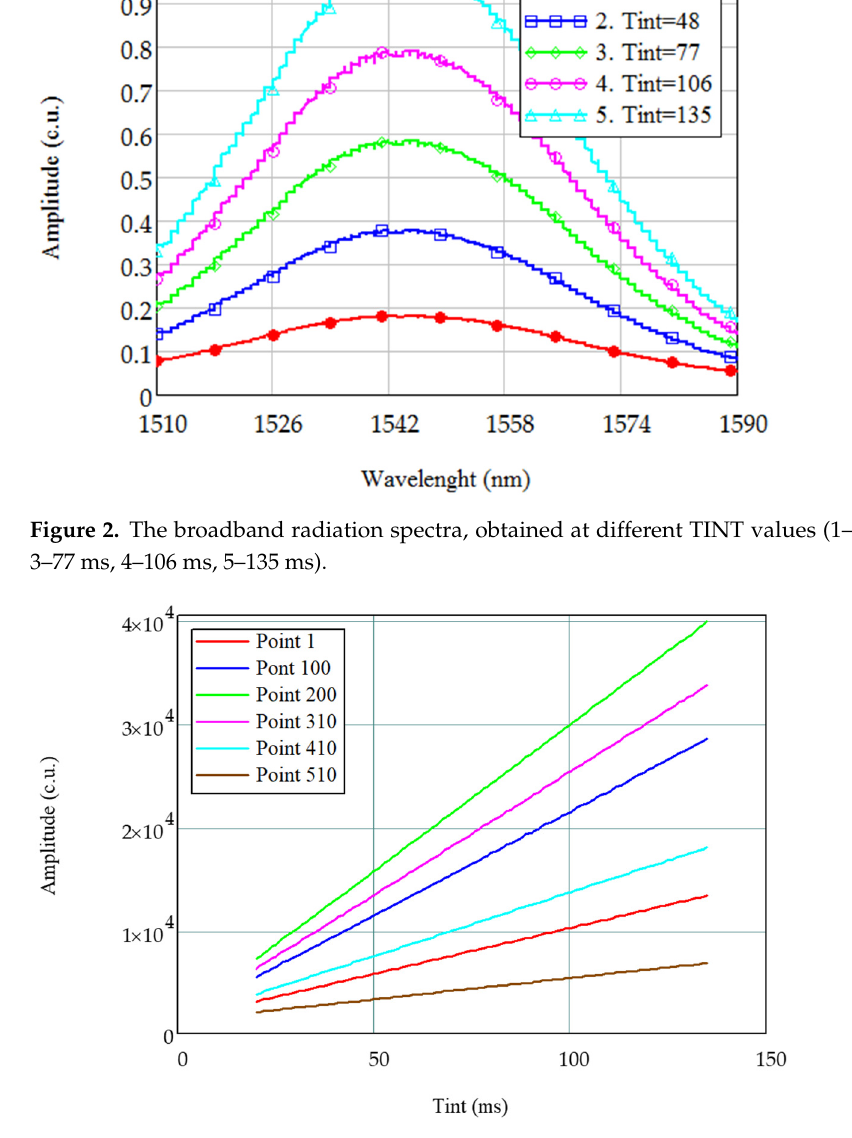
Initial Amplitude (c.u.) Figure 4. Dependence of the slope on the initial amplitude. 4. Mathematical Processing The spectral response of the broadband source radiation for initial TINT value ( t 0 ) can be obtained: